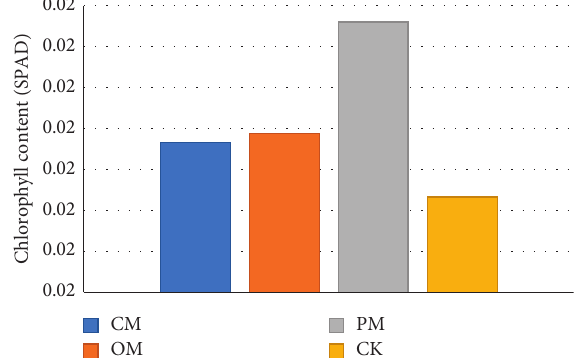
Figure 3: Chlorophyll content of Magnolia spp. under different mulching.